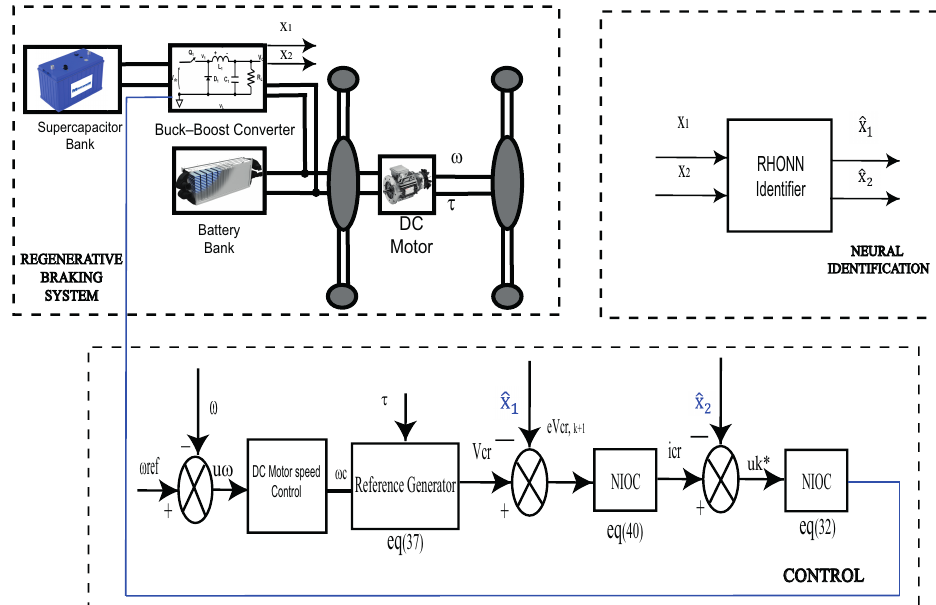
Figure 17. Regenerative braking system control